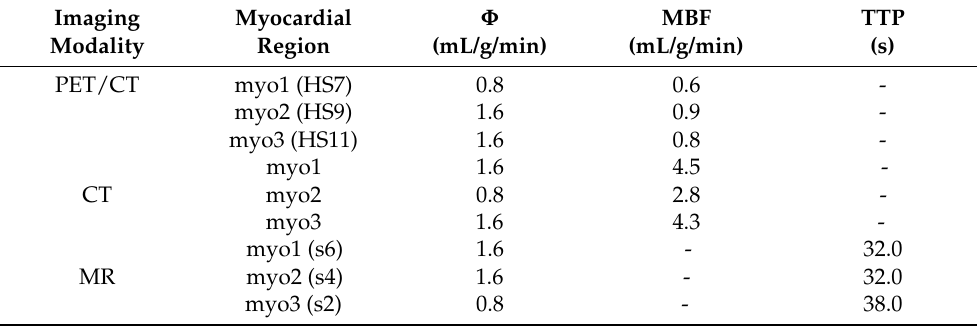
Table 2. Impression of software derived myocardial blood flow (MBF) or other perfusion measures from a reference phantom measurement in PET/CT, CT, and